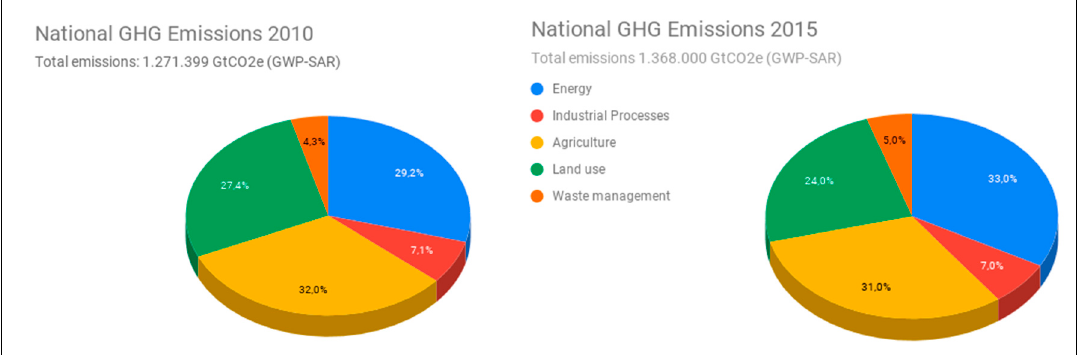
Figure 1. National GHG emissions in 2010 and 2015 [40].